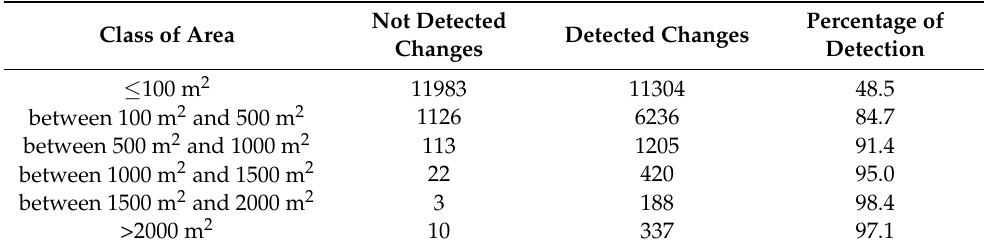
Table 4. Count of real changes identified in the third approach, by at least one pixel, grouped by class of